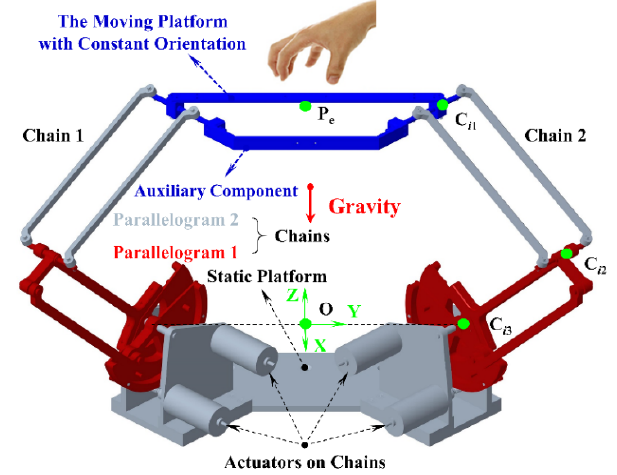
Figure 1. Parallel haptic device with Delta-like